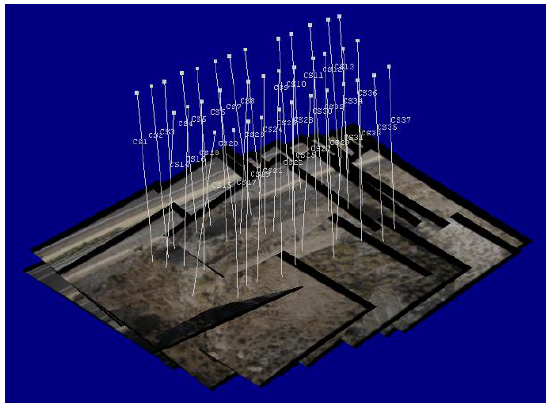
Figure 6. Mosaic of the project photos and points where the photos were taken from